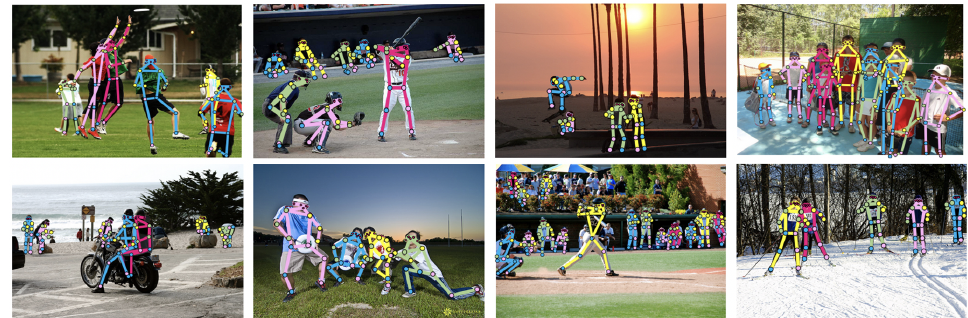
Figure 5. Pose estimation results using BAPose with the COCO